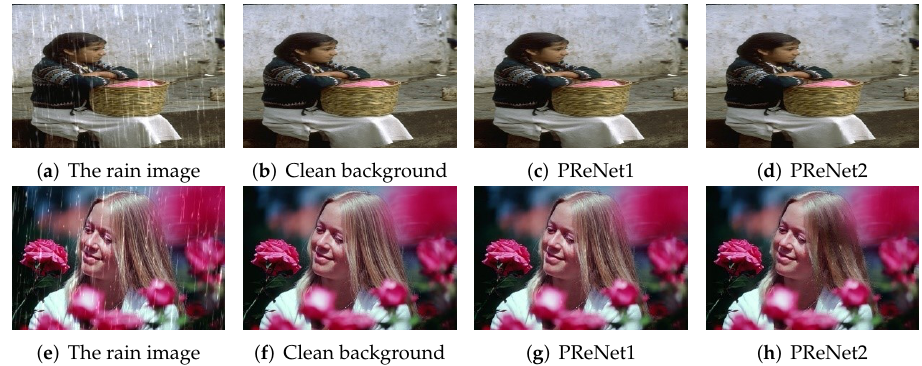
Figure 10. Test results of PReNet 1 and PReNet 2 on two synthetic rain images from the Rain 100 L . PReNet 1 and PReNet 2 represent the different models that are trained on Rain 100 L and Rain Vehicle Color -24 training subsets, respectively.